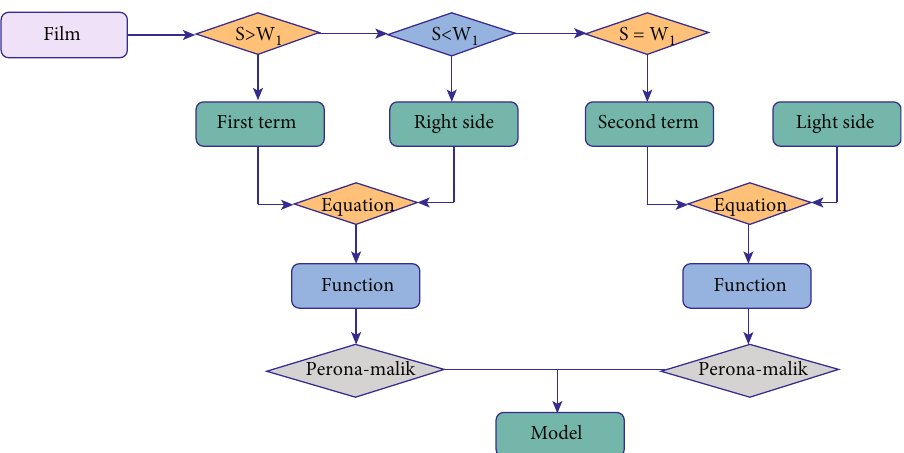
Figure 3: Flow chart of image information partitioning for fi lter di ff usion scheme.